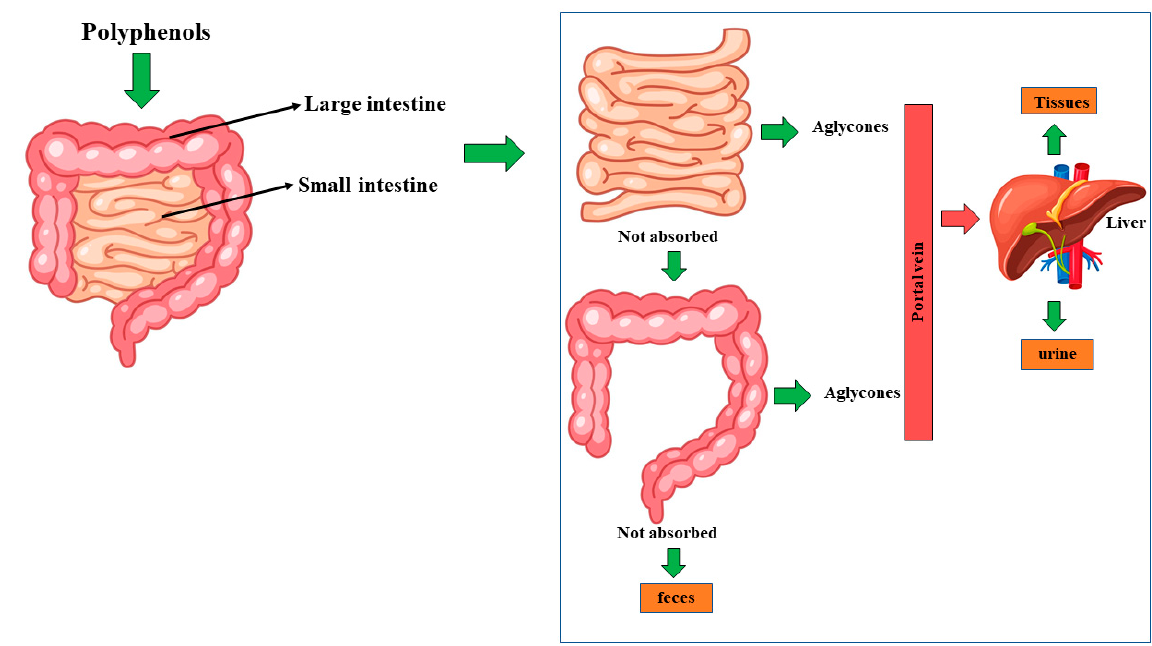
Figure 1. Absorption and metabolism for dietary